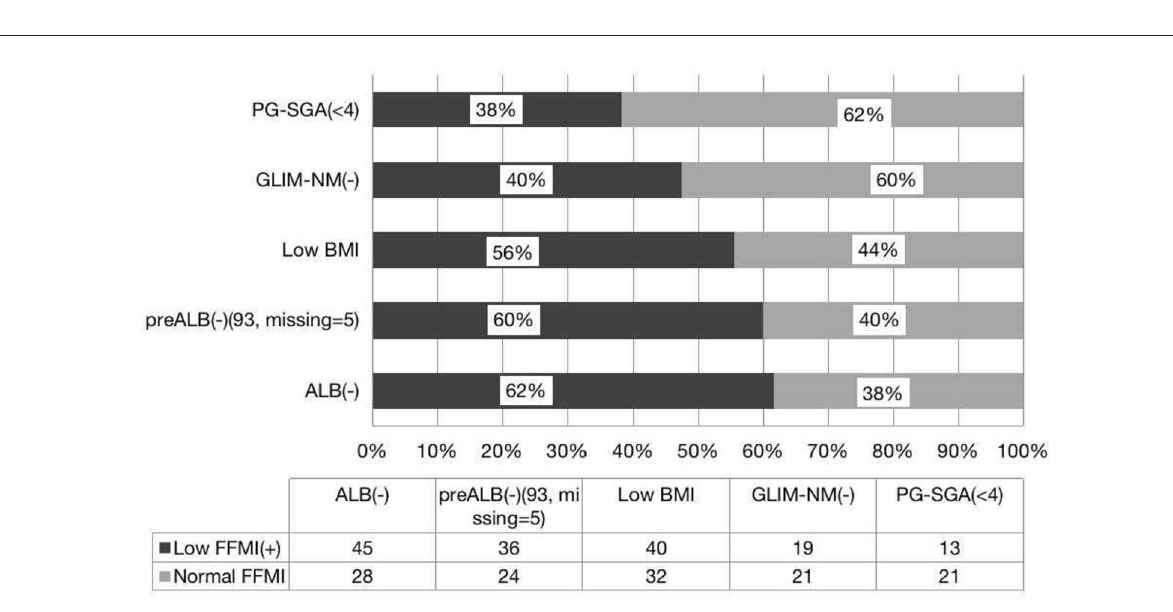
and ASMI are helpful for finding malnourished patients with HSCT who are missed by the PG-SGA scale and GLIM-China.